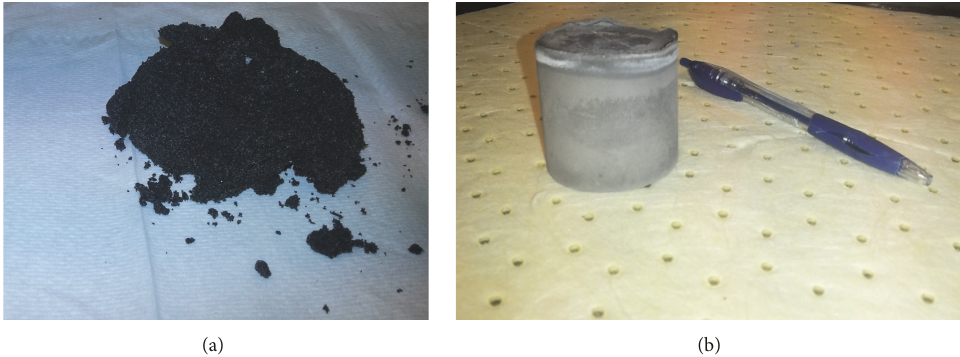
Figure 2: Effect of particle size on the reactivity at 87 ∘ C and ambient pressure: (a) nonground norite and (b) ground norite.